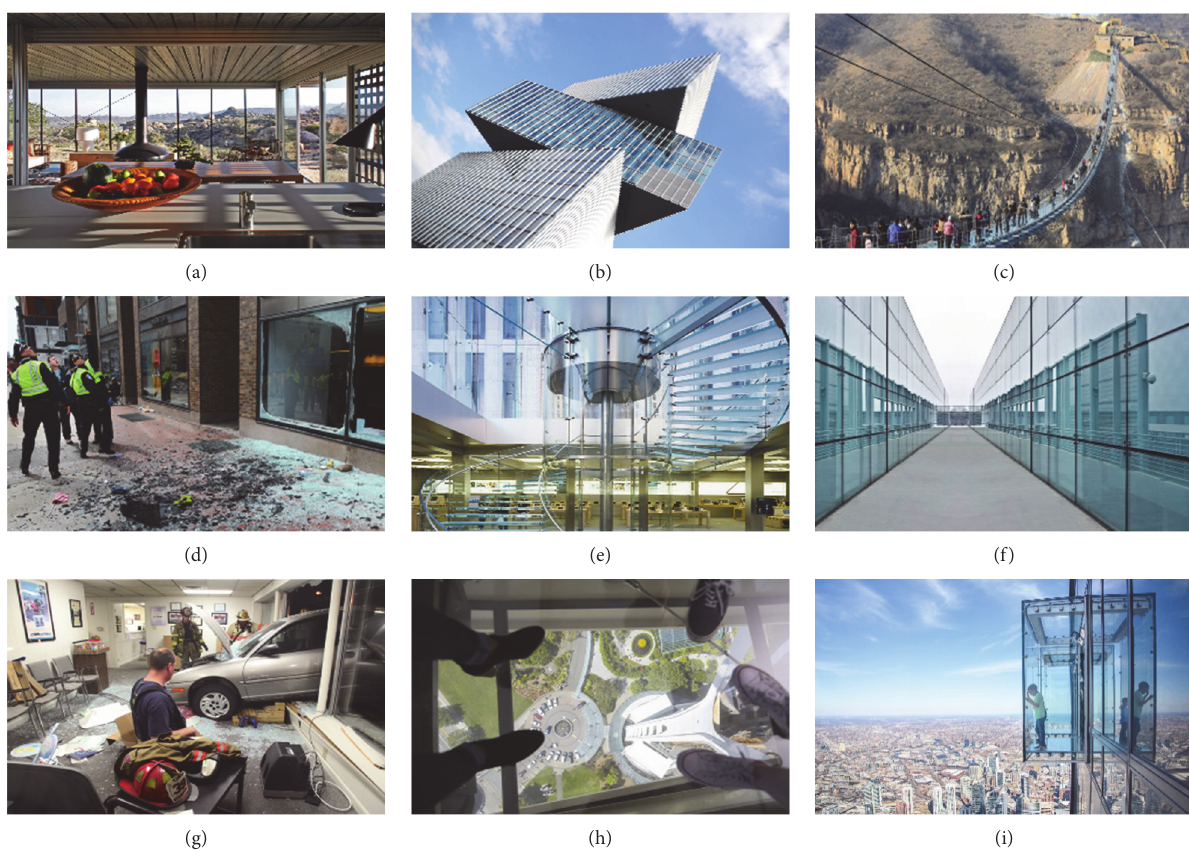
Figure 9: Selection of static input sources for the static VR experiment: (a) private room (Off-grid itHouse, Pioneertown, USA; © Airbnb); (b) Amsterdam RAI Hotel, NL (courtesy of © A Bakker); (c) Hongyagu bridge, Hebei, CN (© REUTERS/Stringer); (d) windows under blast hazard; (e) stair (Apple Cube, New York, USA, © Sedak GmbH & Co KG); (f) facade and walls; (g) window under vehicle impact; (h) Space Needle tower (Seattle, WA, USA); (i) skyscraper (Willis Tower, Chicago, USA). (a) Item #1; (b) item #2; (c) item #4; (d) item #6; (e) item